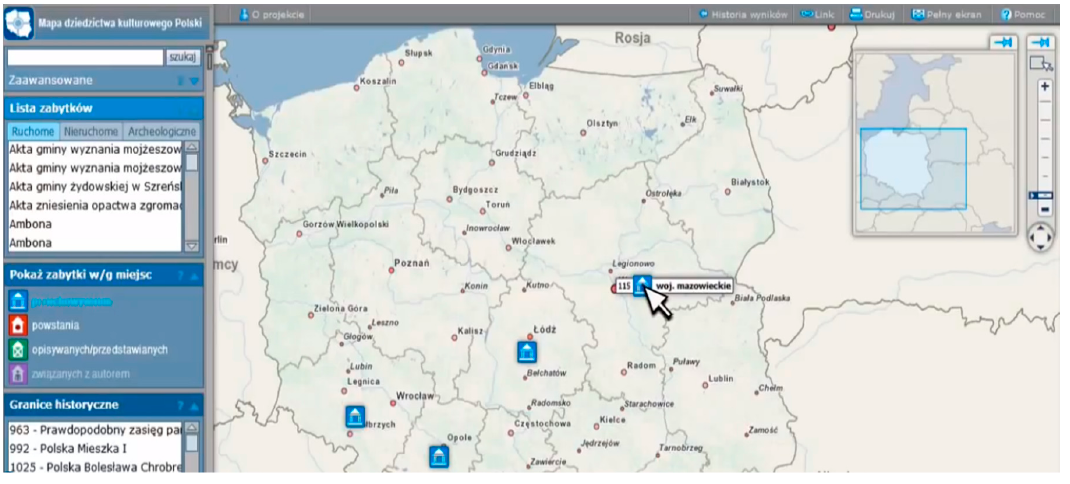
Figure 9. On-line access (geoportal) to the database about monuments with spatial reference (source: own work, formerly presented on www.geoheritage.polska.pl).